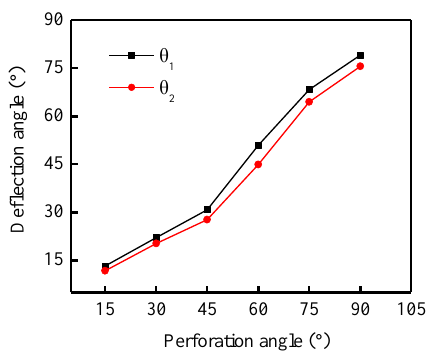
Figure 8. Relationship between perforation angle and two deflection angles ( θ 1 and θ 2 corresponding to quarter-length (10 m) and the half-length (20 m) deflection angle, respectively).